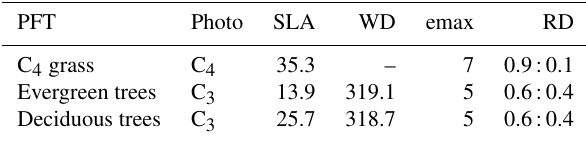
Table 2. Important PFT parameter values used in LPJ-GUESS: pho- tosynthetic pathway (Photo), specific leaf area (SLA, m 2 kgC − 1 ), wood density (WD, kgCm − 3 ), maximum daily evapotranspiration rate (emax, mmd − 1 ) and root distribution (RD, fraction of the root biomass in the upper and lower soil layer, respectively) (Gerten et al., 2004; Nielsen, 2016; Sibret, 2017; Sibret et al.,